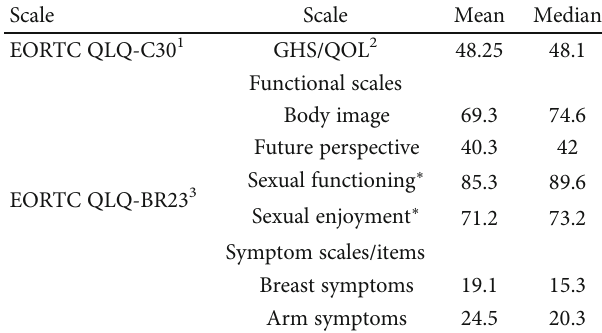
Figure 2: Site of a ff ected breast (mastectomy done) (SPHMMC, 2018). Table 2: QOL, functional capacity, and symptom scales of female breast cancer patients, mastectomy-related quality of life (SPHMMC, Addis Ababa, Ethiopia,